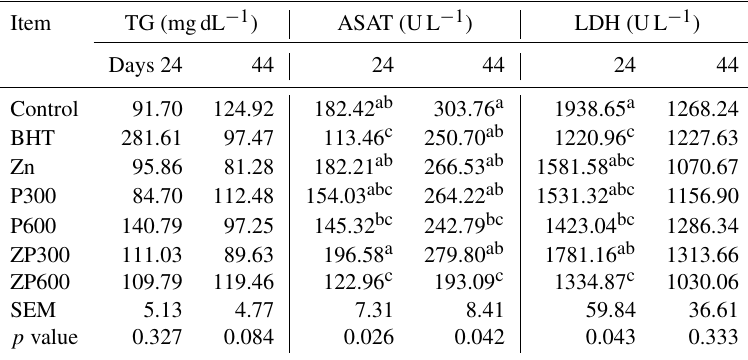
Table 3. Effects of dietary Zn and PHE on the serum level of TG, ASAT and LDH activity in broiler chickens. a-c means that results with the same superscript in each row are not significantly